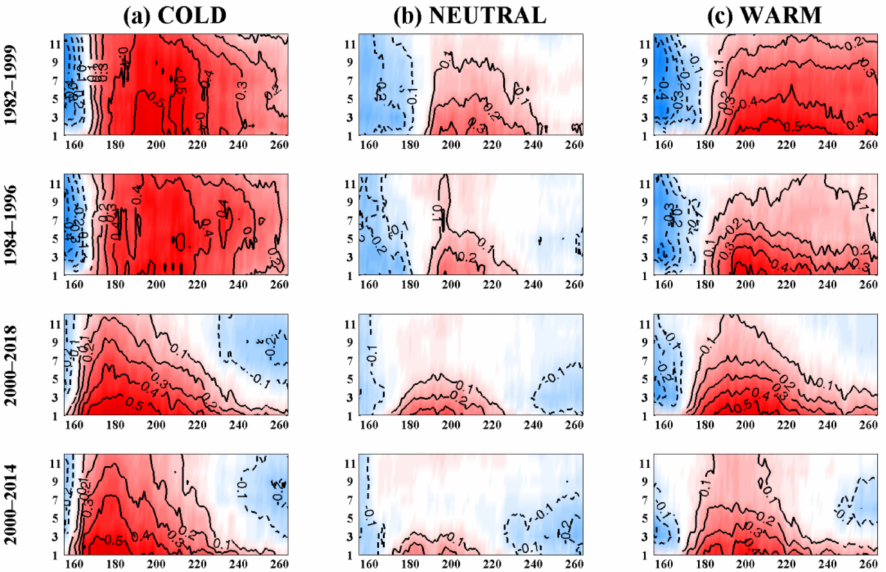
Figure 9. Brier skill score method (BSS) distribution in the equatorial Pacific for the COLD ( a ), NEUTRAL ( b ), and WARM ( c ) SSTA categories as a function of longitude and lead time (in months) for the four